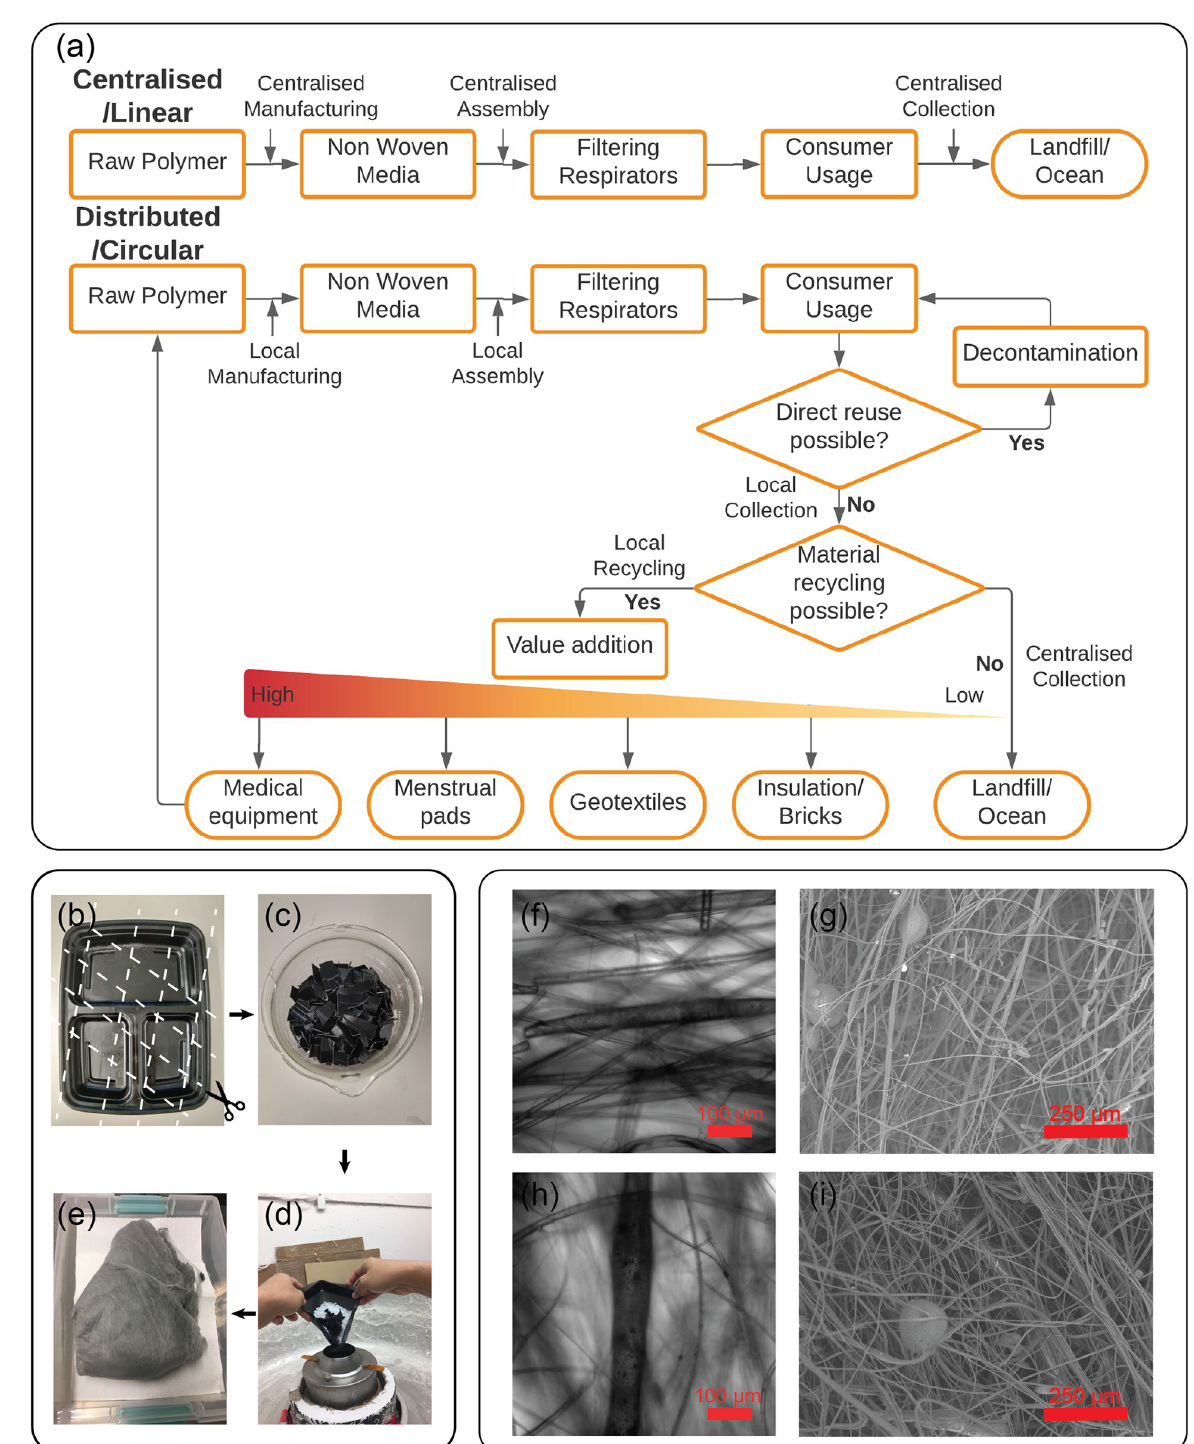
Fig 4. Incorporation of locally sourced recycled material. A: A distributed manufacturing framework enables incorporation of cycles within material life from raw polymer to dumping sites at landfills or oceans. Access to machines like the one presented in the study allows addition of value during recycling process, improving the chances of the material to be reused for multiple applications during its lifetime. B-E: Locally sourced waste polypropylene was cut into small pieces and combined with virgin 1112 PP resin at 1:5 ratio to produce fiber sheet. F-H: Light micrographs of thick fiber stems at 30x magnification. Phase separated droplets of waste material are visible inside as dark inclusion, which increase in number as we go from 20% (F) to 80% (H) proportion of recycled polymer. G-I: SEM characterization of the recycled-PP/PP hybrid showing unnoticeable variation in fiber morphology as we go from 20% (G) to 80% (I) proportion of recycled polymer.